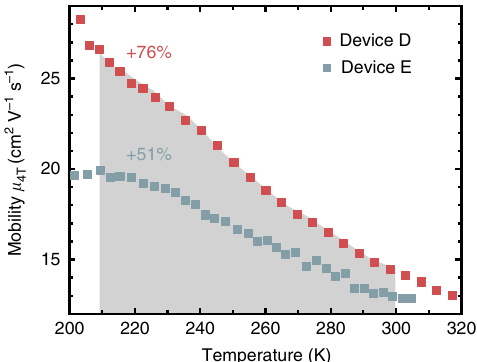
Figure 5 | ‘Band-like’ transport in C 10 -DNBDT-NW single-crystal thin films. The increasing mobility at lower temperature shows the dominating influence of thermal fluctuations on charge transport. The increase by 76% within a decrease of temperature by 85K (highlighted in grey) is in line with the calculations, which showed that the reduction of thermal fluctuations due to strain is equivalent to a temperature reduction by